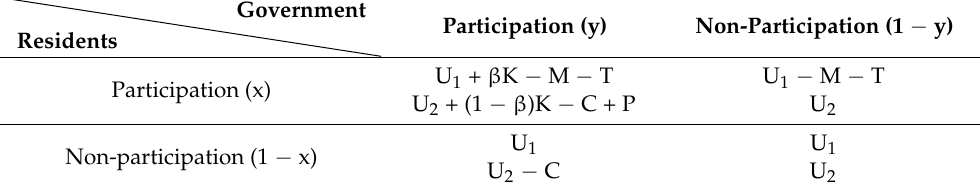
Table 1. Game payment matrix for participation in waste-separation